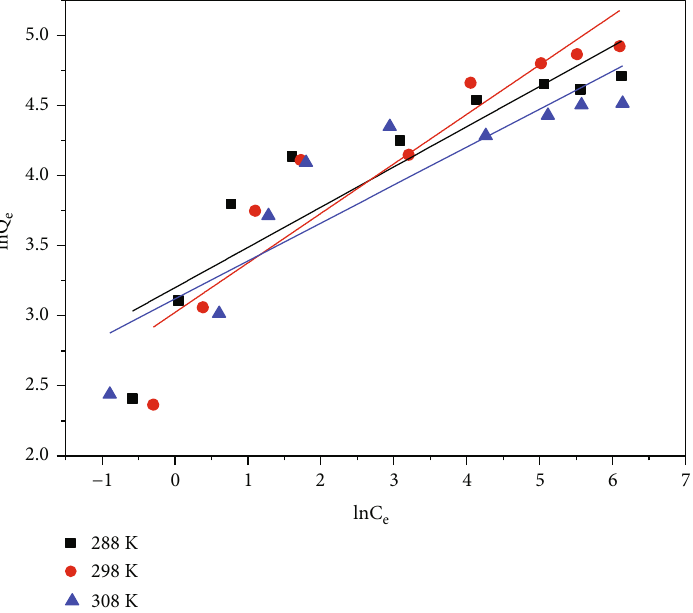
Figure 10: Freundlich isotherm for Cr (VI) removal on